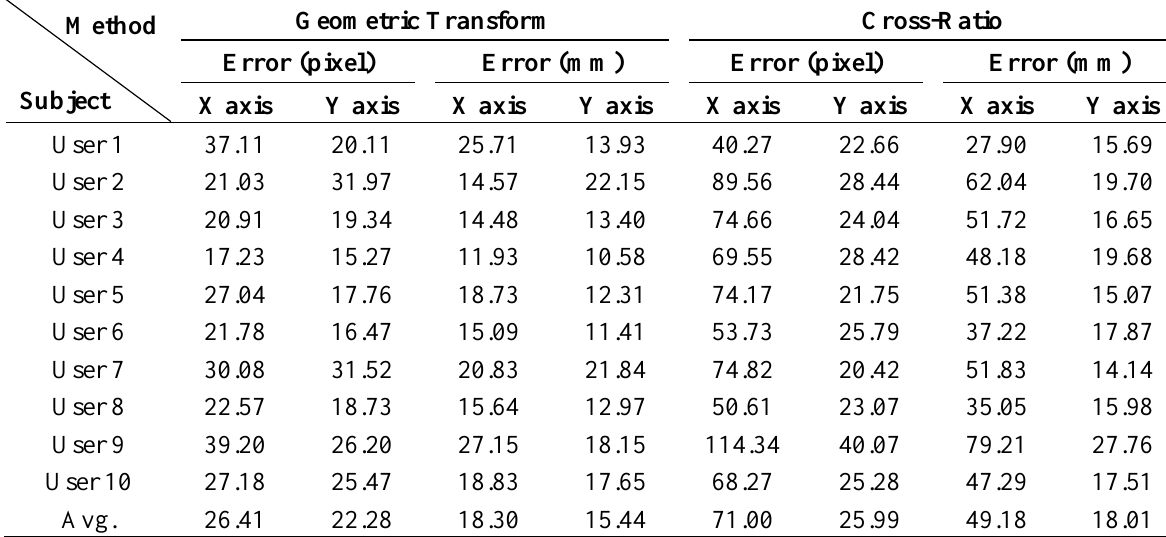
Table 4. Comparisons of gaze tracking error by our geometric transform-based method to that by cross-ratio based one in each subject—(2) (unit: pixel or mm).